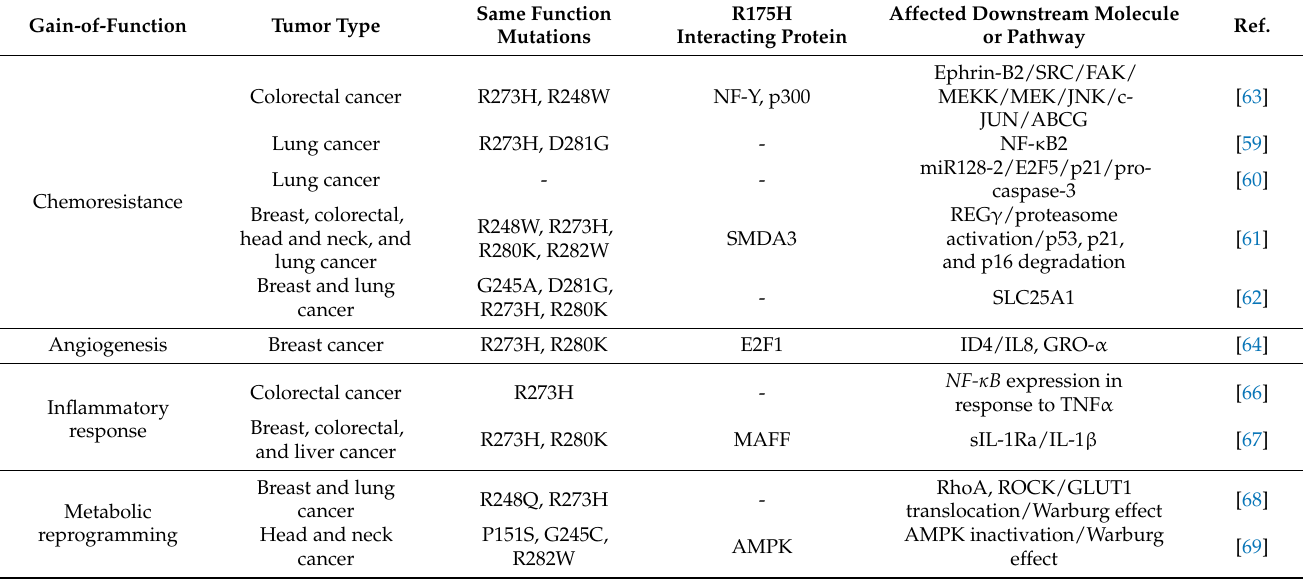
Table 6. Summary of p53-R175H gain-of-function of promoting tumor drug-resistance, inflammation, angiogenesis, and metabolic reprogramming.